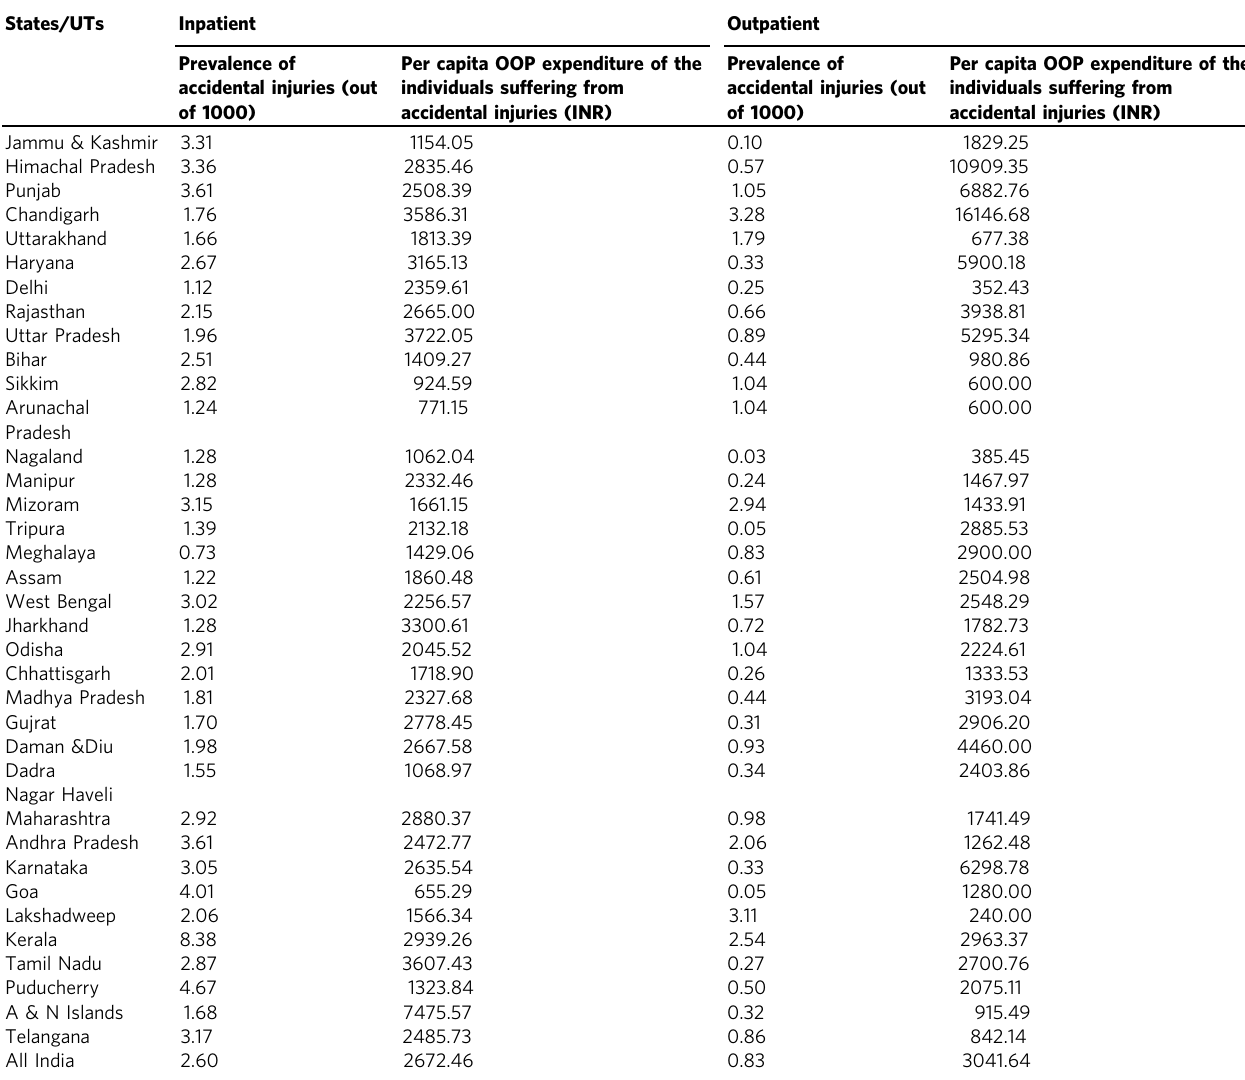
Figures are based on the author ’ s calculations from the NSSO 75th